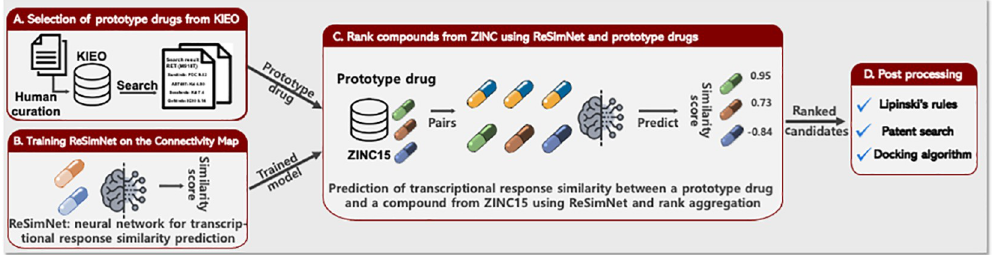
Fig 6. A schematic summarizing DMIS-MTD’s method. The method was based on ReSimNet [33], a Siamese neural network model that predicts their transcriptional response similarity of two compounds. (A) Several prototype drugs whose kinase inhibition profiles satisfy most of the pro-target and anti-target conditions of the challenge problem were identified using the KInase Experiment Omnibus (KIEO) database. (B-C) ReSimNet, trained on the CMap dataset, was used to predict the transcriptional response similarity between a prototype drug and a novel compound from ZINC15. (D) Finally, the top- ranking ZINC15 compounds are aggregated and filtered for compounds that fulfill Lipinski’s rules, a patent search through PubChem, and a protein-ligand docking